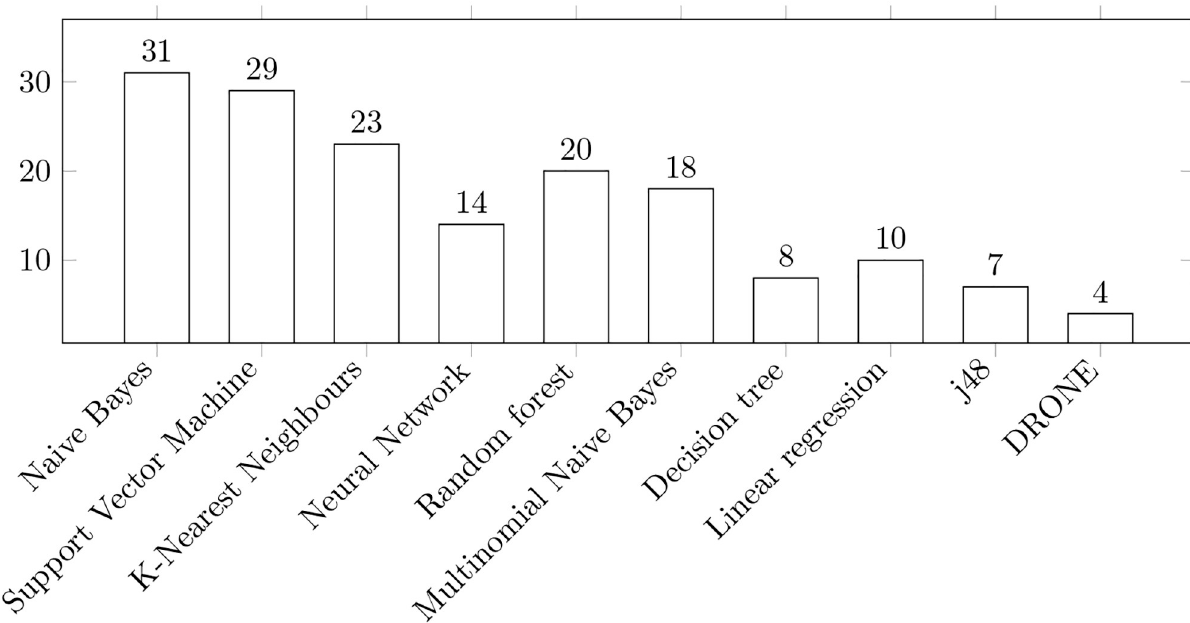
Fig 9. Algorithms used in the papers included in the final reading log. The bars show the number of papers in which the specified algorithms were considered. Note: several algorithms can be considered in one paper.